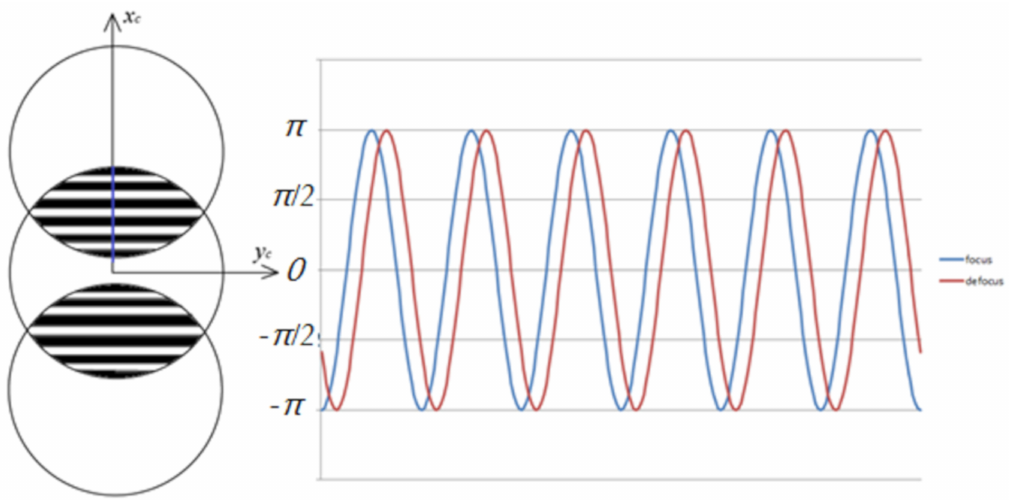
Figure 5. Simulation of phase shift at focus and defocus